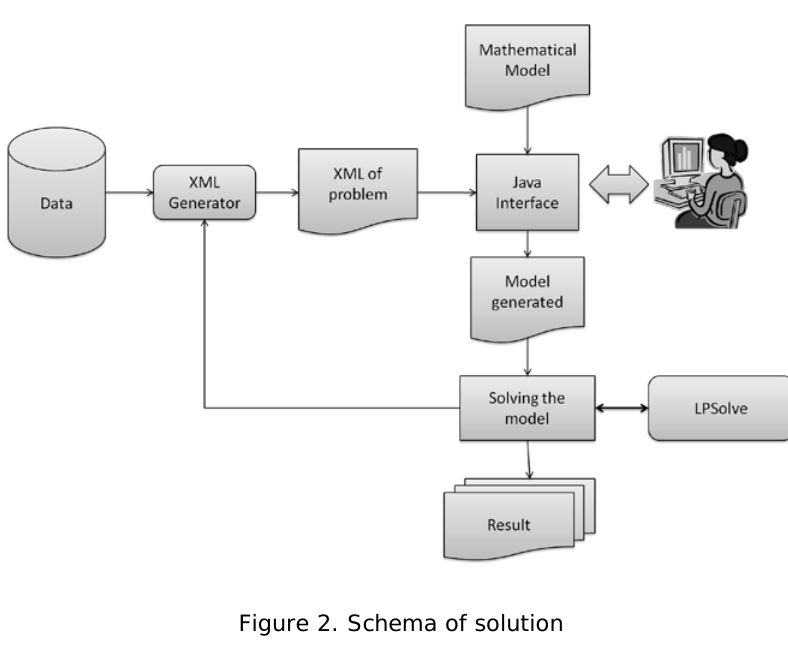
Figure 2. Schema of